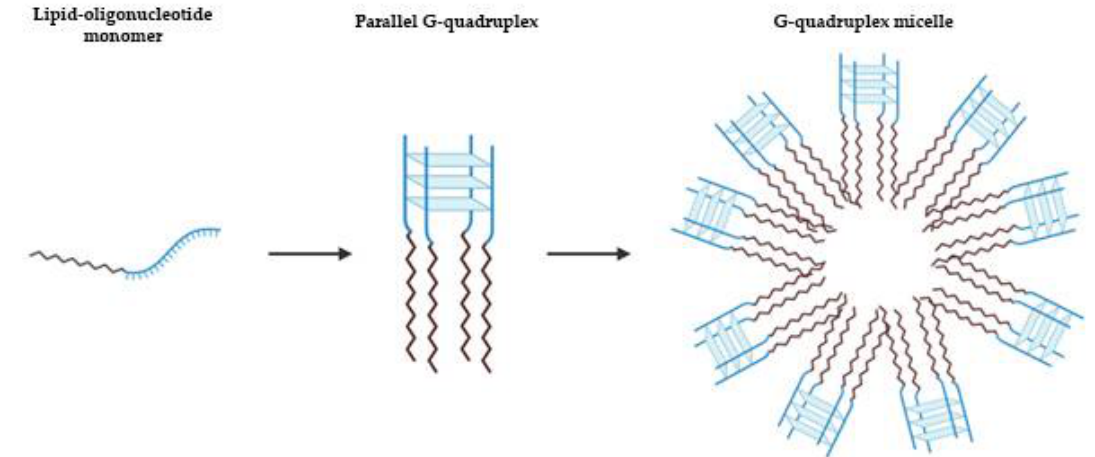
Figure 6. Schematic representation of lipid-driven assembly of tetramolecular parallel G4s. Depending on the nature of the lipid, the sequence of oligonucleotide and of salts present, the tetramolecular parallel G4 can result in micellar assemblies [82].